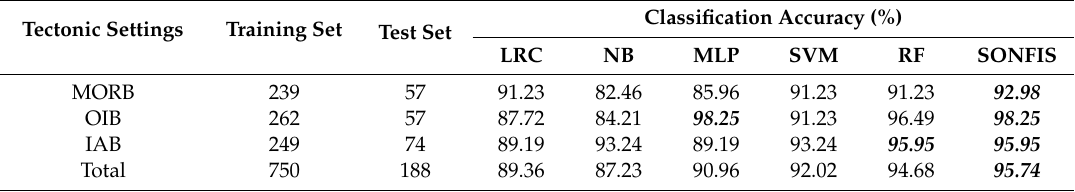
Table 4. Classification accuracy of tectonic discrimination of basalts in dataset 1 based on six MLAs. Tectonic Settings